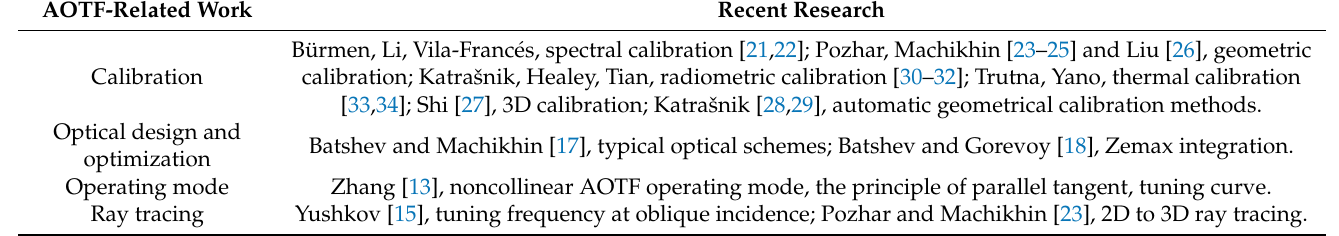
Table 1. The works related to AOTF in recent